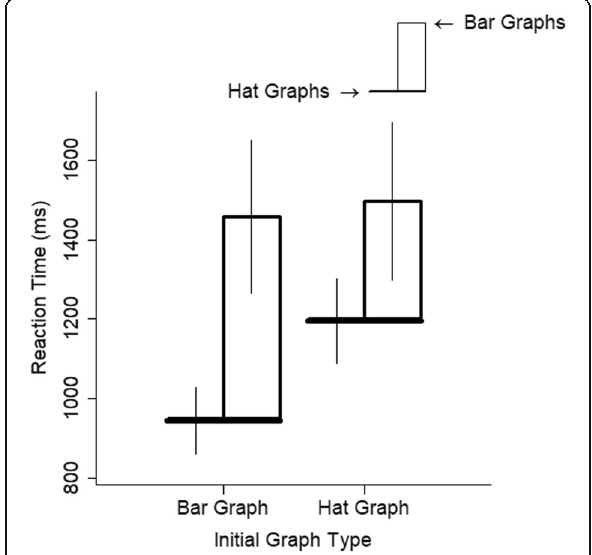
Fig. 10 Reaction time (RT) is plotted as a function of graph type and start condition for experiment 2. The brim of the hat corresponds to the RTs for the hat graph condition, and the top of the crown of the hat corresponds to RTs for the bar graph condition. The size of the crown indicates the difference in RTs between the two conditions. Error bars are ±1 SEM based on estimates from the linear mixed